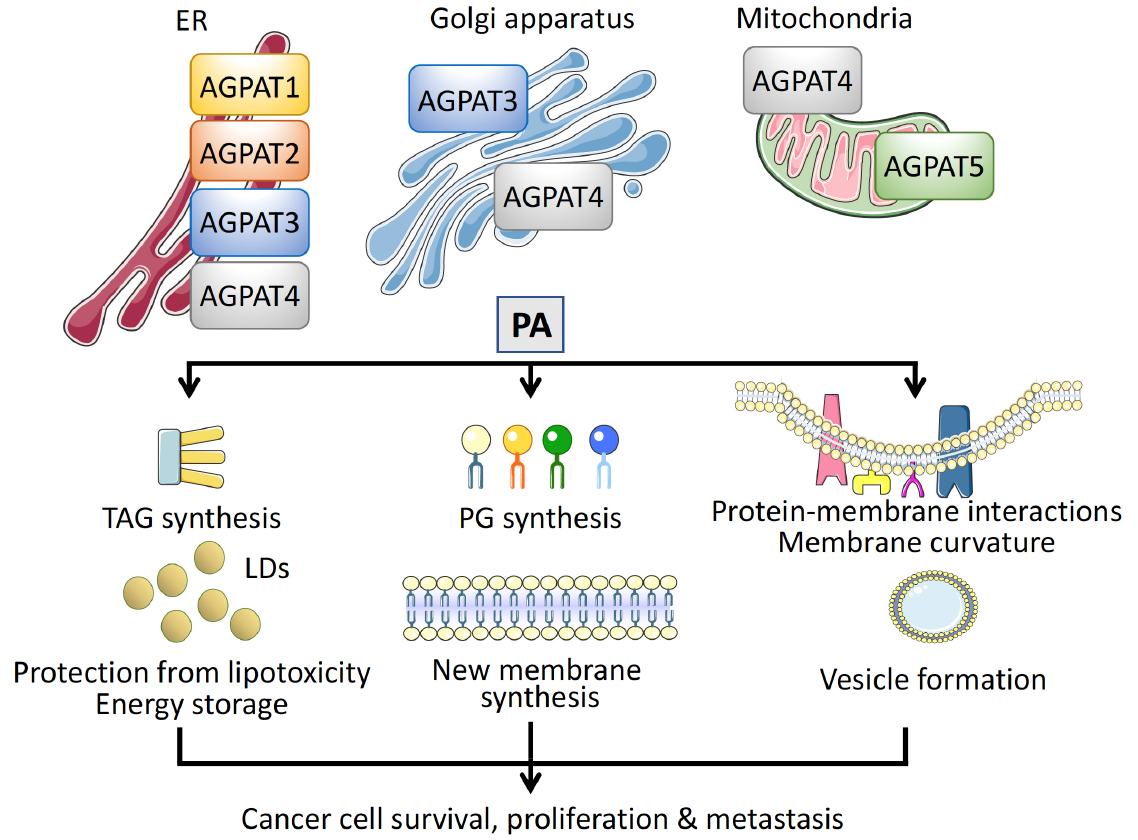
Figure 3. Intracellular localization and function of AGPATs. Different membrane compartments are populated by specific AGPAT isoforms. Isoforms AGPAT1–4 have been localized on the endoplasmic reticulum (ER), AGPAT3, and AGPAT4 on the Golgi apparatus, and AGPAT4 and AGPAT5 on mitochondria. Phosphatidic acid (PA) synthesized via the catalytic activity of AGPATs has multiple roles in cells, promoting cancer cell survival, proliferation, and metastasis. First, PA is an intermediate for the synthesis of TAGs, which are stored in lipid droplets (LDs), protecting cancer cells from free FA toxicity and serving as energy reservoirs. Second, PA is a precursor of phosphoglycerides (PGs), essential for new membrane synthesis in rapidly proliferating cancer cells. Third, insertion of PA regulates protein–membrane interactions, causes membrane curvature, and participates in vesicular transport, mediating cancer cell metastasis.